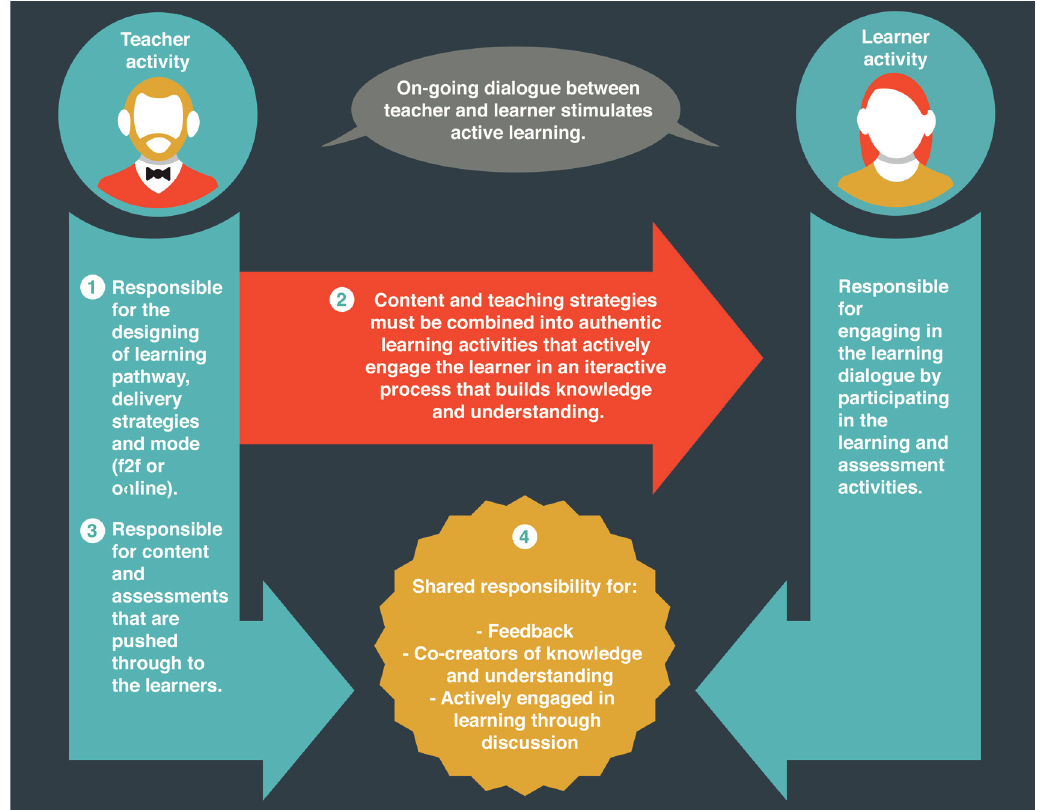
Figure 1. The Learning pathway, delivery strategies and shared responsibility in the learning environment. Based on Laurillard’s conversation model reflecting teacher/student interaction (BTBL Bytes,